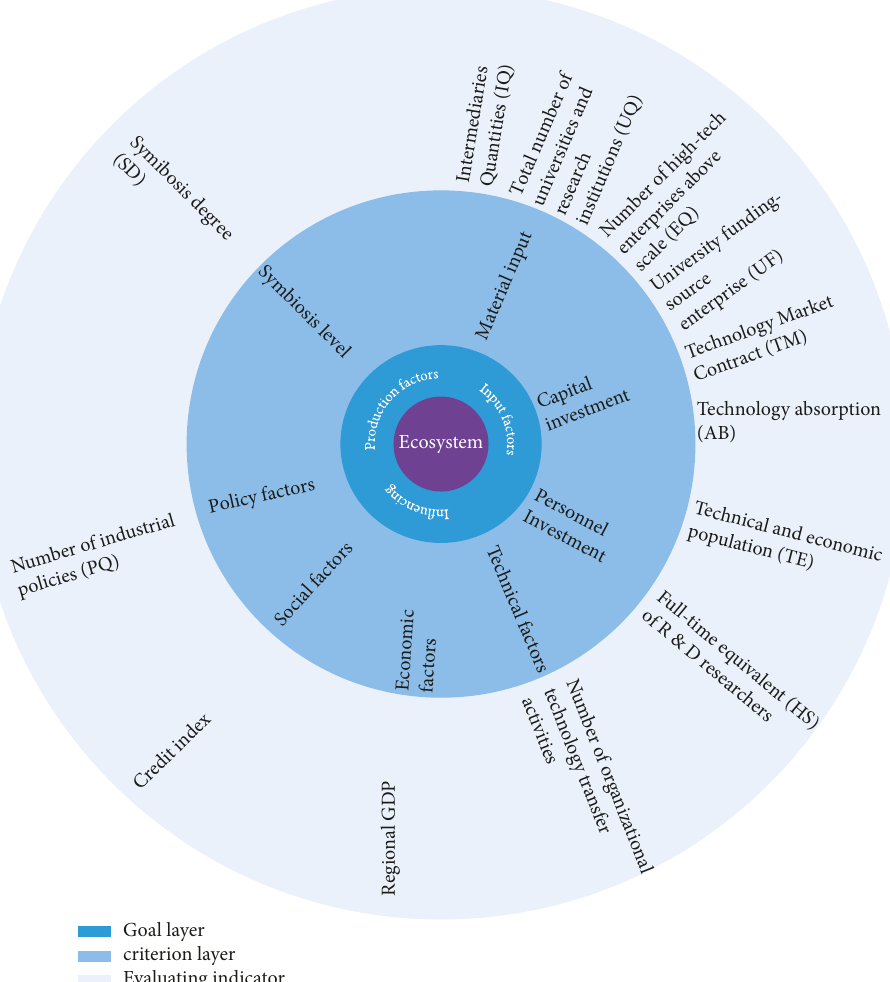
Figure 2: Evaluation index system of the symbiotic efficiency of the high-tech industrial innovation